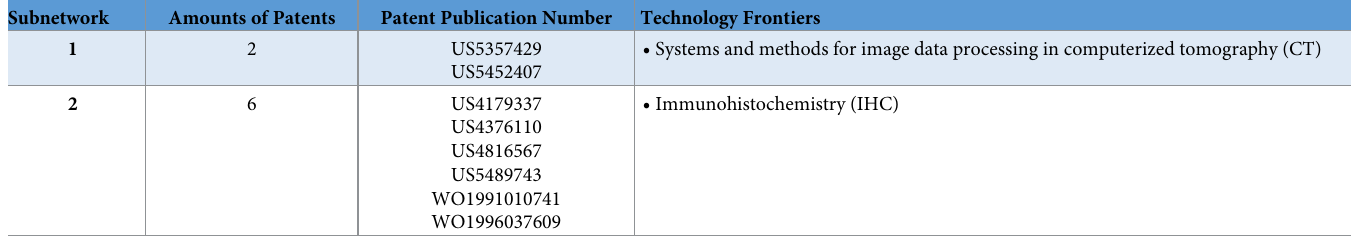
Table 1. The technology frontiers from 1992 to